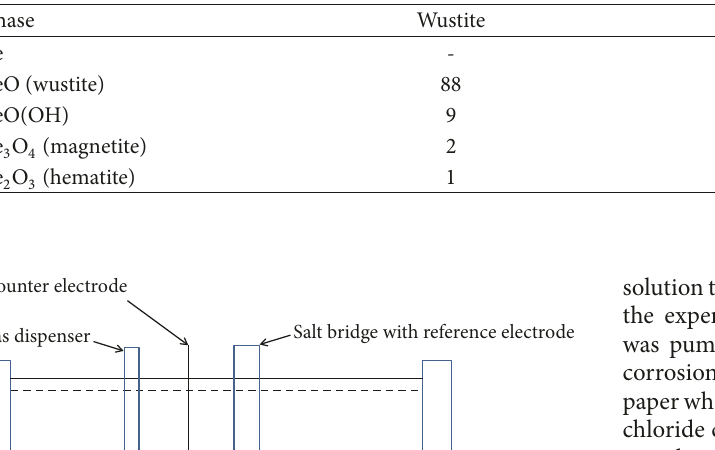
Table 3: Calculated composition from XRD spectra of the samples [%].